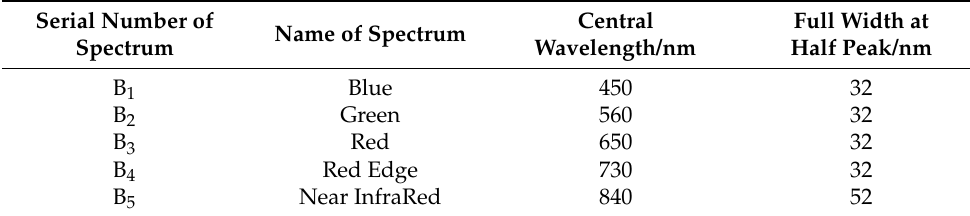
Table 1. Spectral parameters of DJI Phantom 4 Multispectral